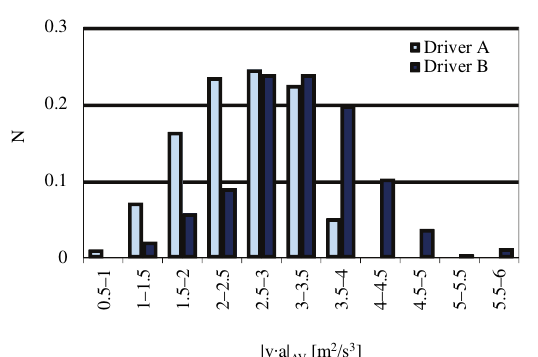
Fig. 16. The average value of the absolute value of the velocity and acceleration product in urban driving conditions